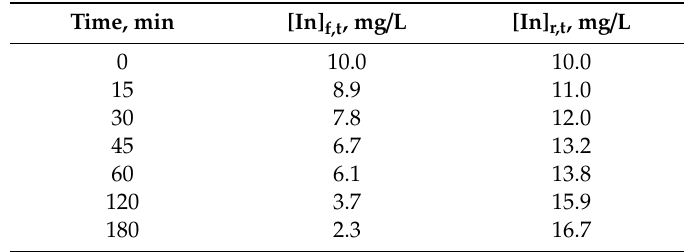
Table 6. Indium concentrations in the feed and receiving phases at di ff erent timepoints. Time, min [In] f,t , mg / L [In] r,t , mg / L 0 10.0